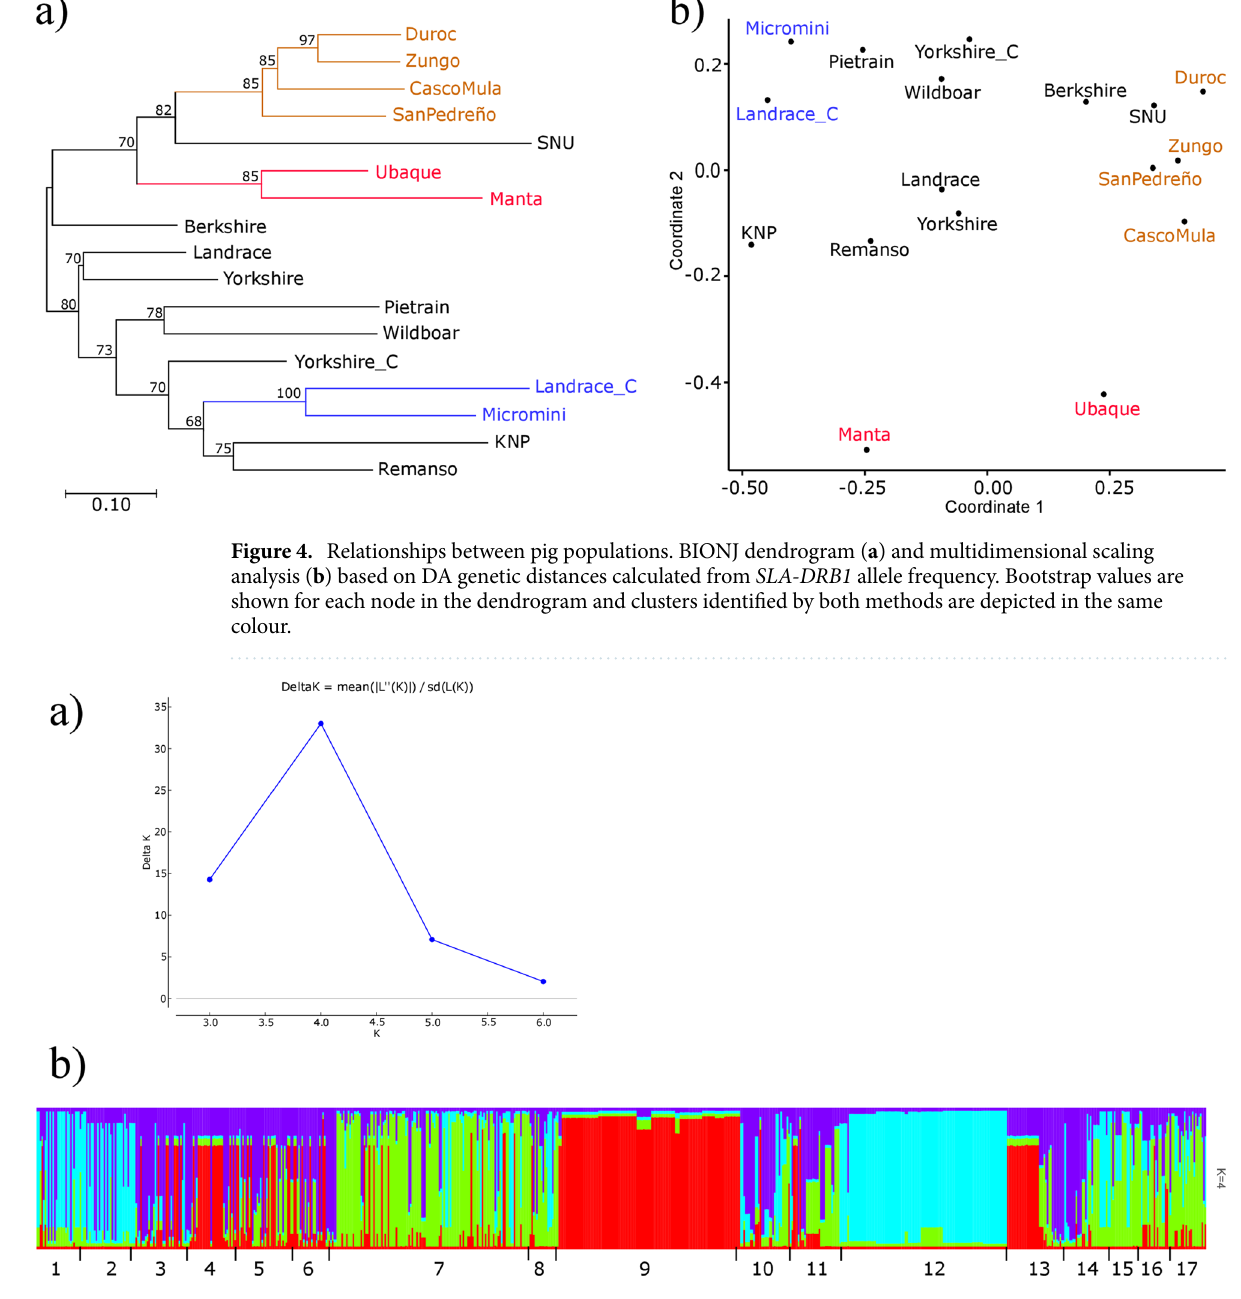
Figure 5. Pig population structure analysis based on Bayesian clustering. Delta K values as a function of K ( a ). Population clustering ( b ). Each vertical line represents an individual and each colour an inferred population. Numbers under ( b ) indicate populations: 1, Remanso; 2, Manta; 3, Ubaque; 4, Casco Mula; 5, San Pedreño; 6, Zungo; 7, Wild boar; 8, Micromini; 9, SNU; 10, Yorkshire; 11, Berkshire; 12, KNP; 13, Duroc; 14, Landrace; 15, Landrace_C; 16, Yorkshire_C; 17,